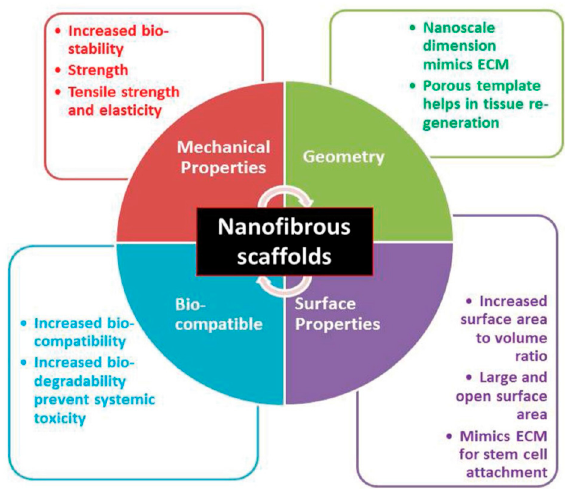
Figure 9. Schematic representation of the required properties of nanofibrous scaffolds including geometry, mechanical competence, biocompatibility and surface behavior.